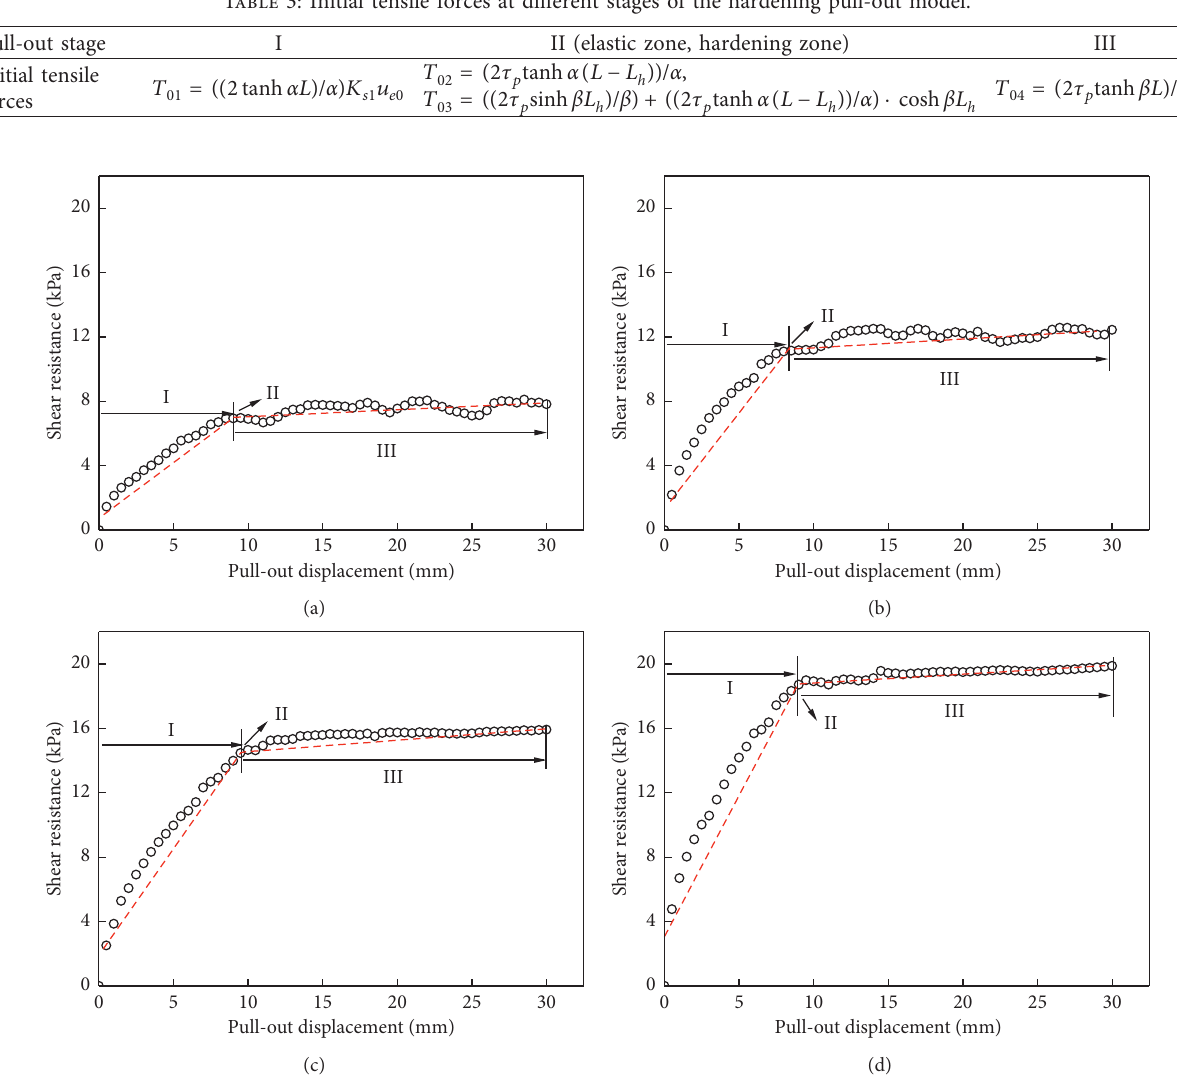
Figure 10: Comparison between the pull-out test results and model-predicted results of geogrids under different normal stresses: (a) 10kPa; (b) 20 kPa; (c) 30kPa; and (d)